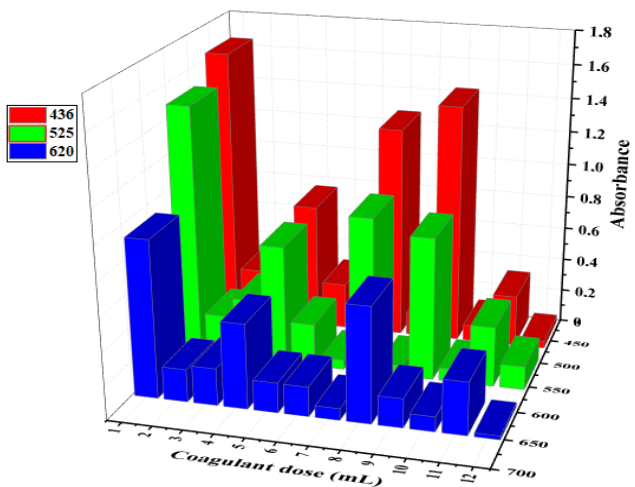
Figure 25. Three-dimensional ( a ) and two-dimensional ( b ) response surface plots for the COD of the treated food wastewater using β-chitin extract as a function of coagulant dose and temperature, when the pH was maintained at 11.